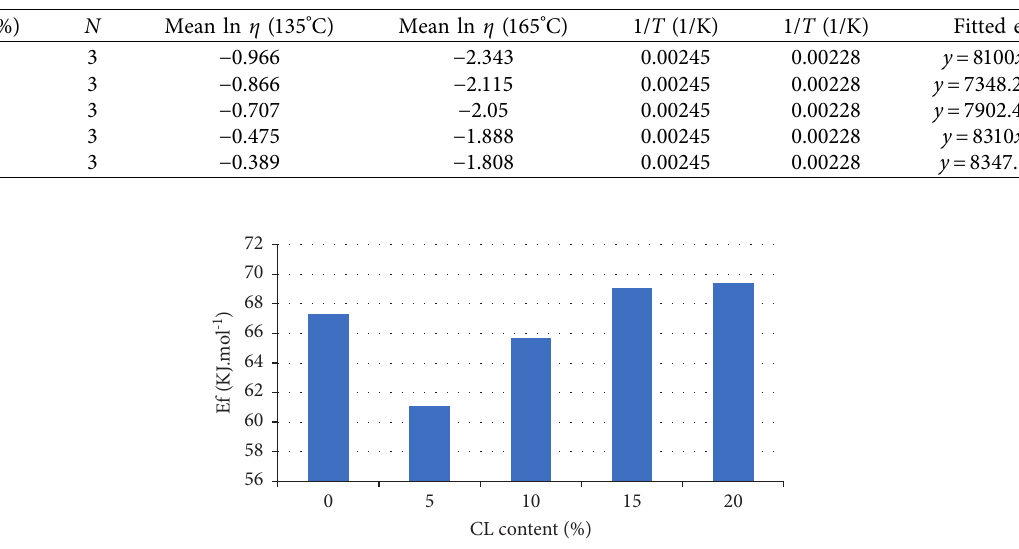
Table 7: Fitted equations for the plot of ln η versus 1/ T .